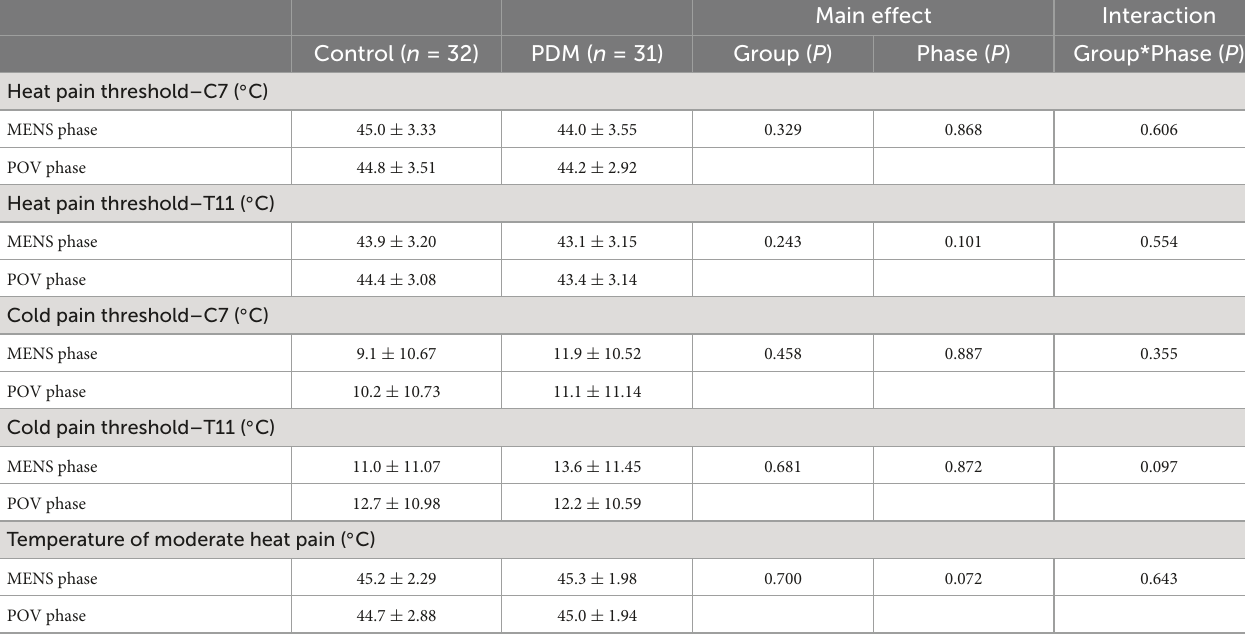
TABLE 2 Results of repeated-measures ANOVA of quantitative sensory testing and temperature of moderate heat pain: Effects of group and menstrual cycle phase.